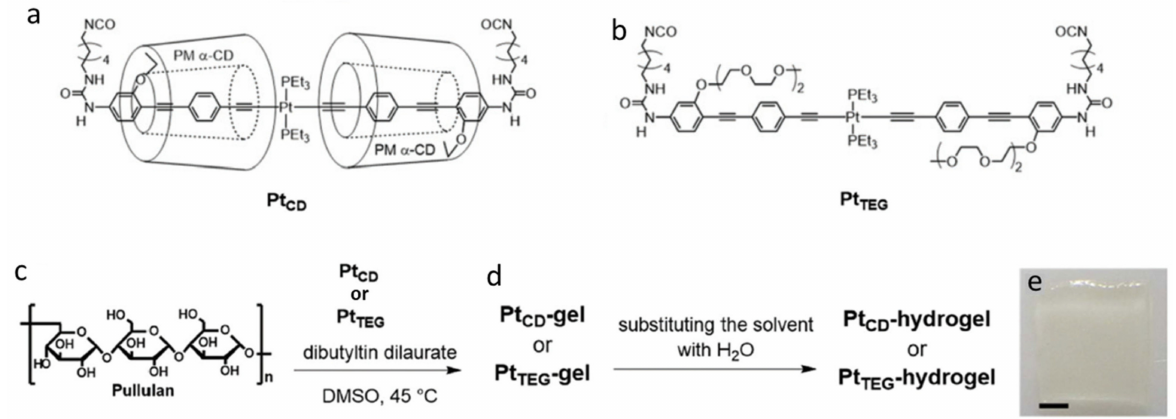
Figure 3. Molecular structure of ( a ) Pt CD ; ( b ) Pt TEG ; ( c ) and ( d ) formation of a Pt CD -hydrogel and Pt TEG -hydrogel and ( e ) photograph of the Pt CD -hydrogel in daylight; scale bar = 1 mm. Republished from [42] with permission of Royal Society of